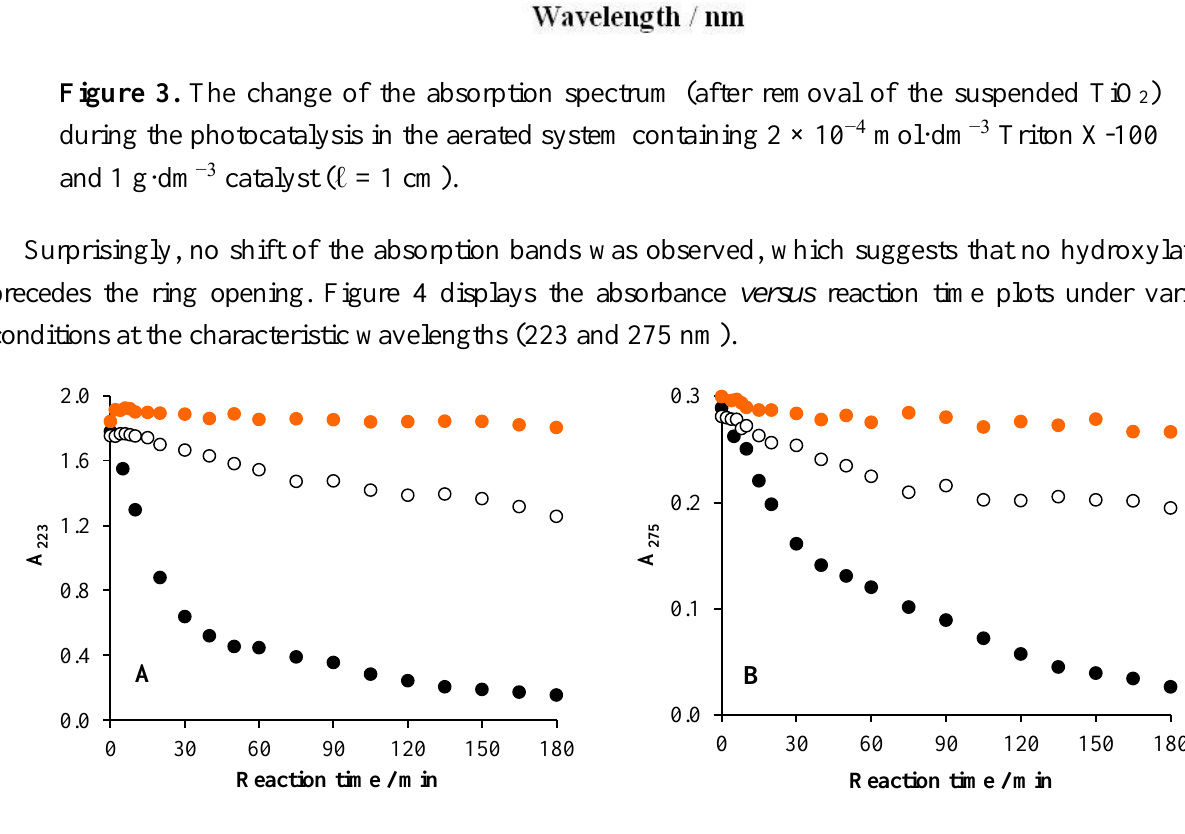
Figure 4. The change of the absorbance at 223 nm ( A ) and 275 nm ( B ) as a function of the reaction time under various conditions in the system containing 2 × 10 −4 mol·dm −3 Triton X-100 and 1 g·dm −3 TiO 2 (ℓ = 1 cm): air (•), air/UV (○) and air/UV/TiO 2